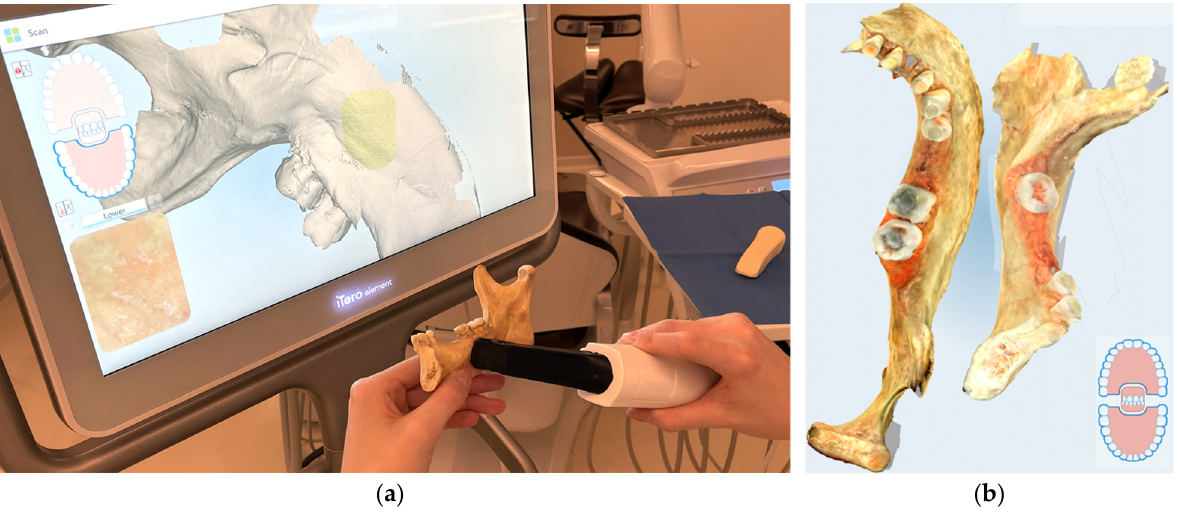
Figure 3. Optical scanning of the mandible: ( a ) iTero Element intraoral scanner (Align Technology, Inc., San Jose, California, USA) and other scanners are commonly available; ( b ) PLY/STL export for comparison to the CBCT-segmented models. This approach confirmed sufficient accuracy of the surface scan, albeit remains were optional, as the surface scan had no morphological information about the inner structure.